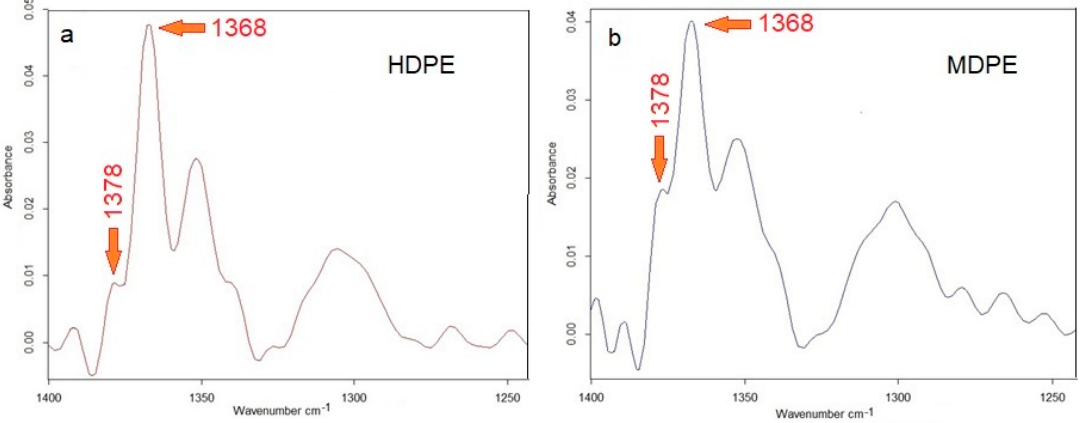
Figure 11. Comparison of FTIR spectra in the range of 1200–1400 cm − 1 for HDPE ( a ) and MDPE ( b ); 1378 and 1368 cm − 1 bands correspond to symmetric scissoring vibrations of CH 3 and CH 2 , respectively.